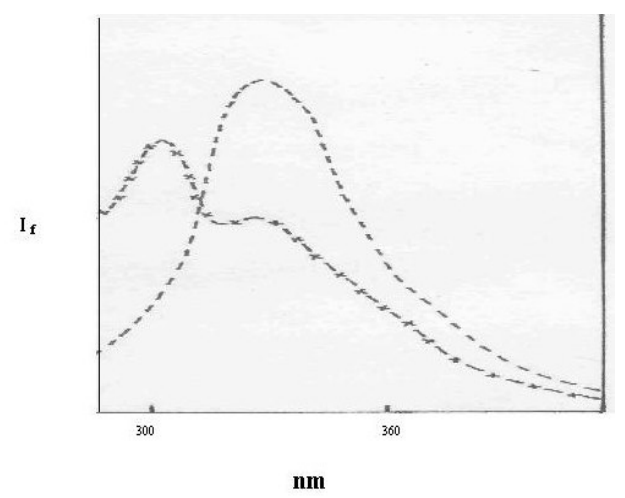
Figure 3 . Flurescence spectra of different species of DAAQ in cyclohexane and cyclohexane-TFA